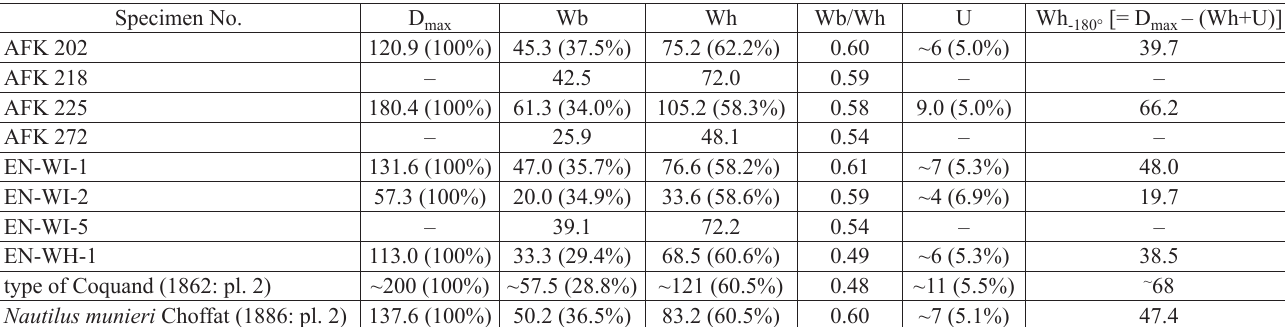
Table 1. Measurements (in mm; in brackets % of D max ) of the studied specimens of Angulithes mermeti (Coquand, 1862), see also Fig. 2. Abbre- viations: D max , maximum diameter; U, size of umbilicus at D max ; Wb, whorl breadth at D max ; Wh, whorl height at D max ; Wh -180° , whorl height at -180° from D max . Specimen